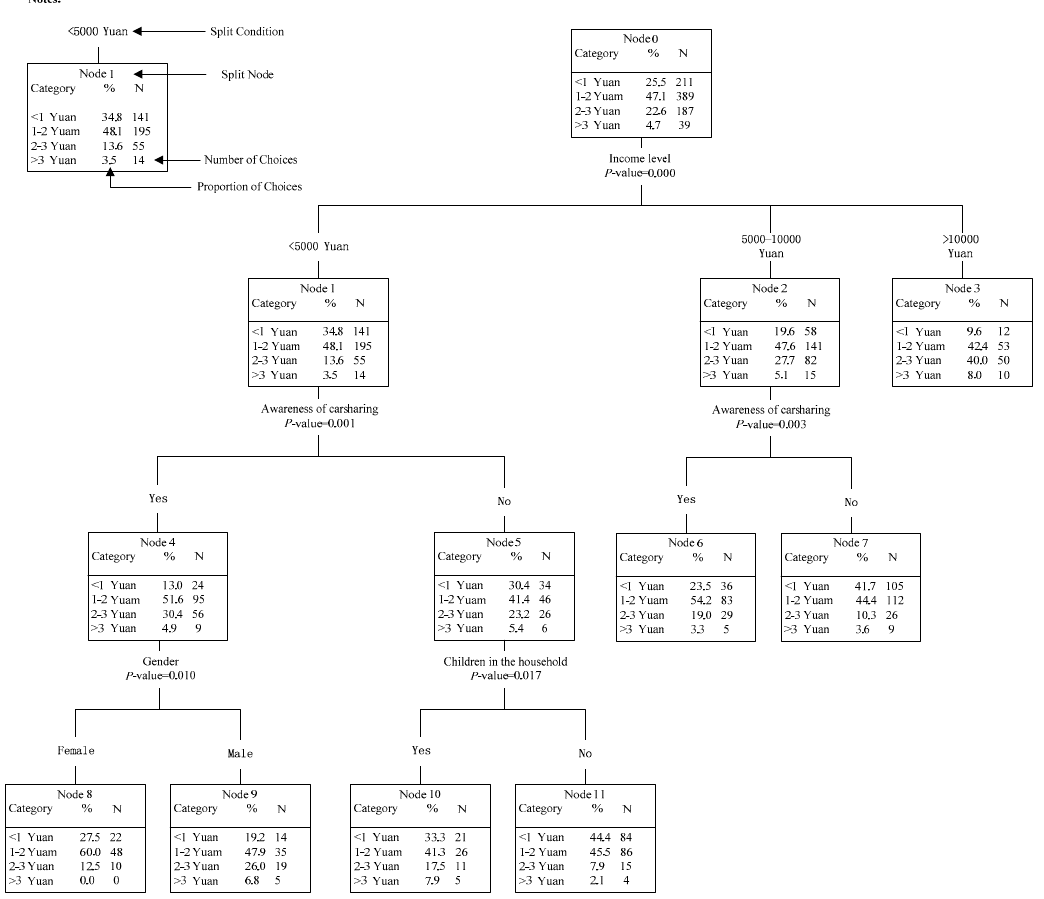
Figure 6. HTBR Model #3: Predicting participants’ highest acceptable price to use carsharing.